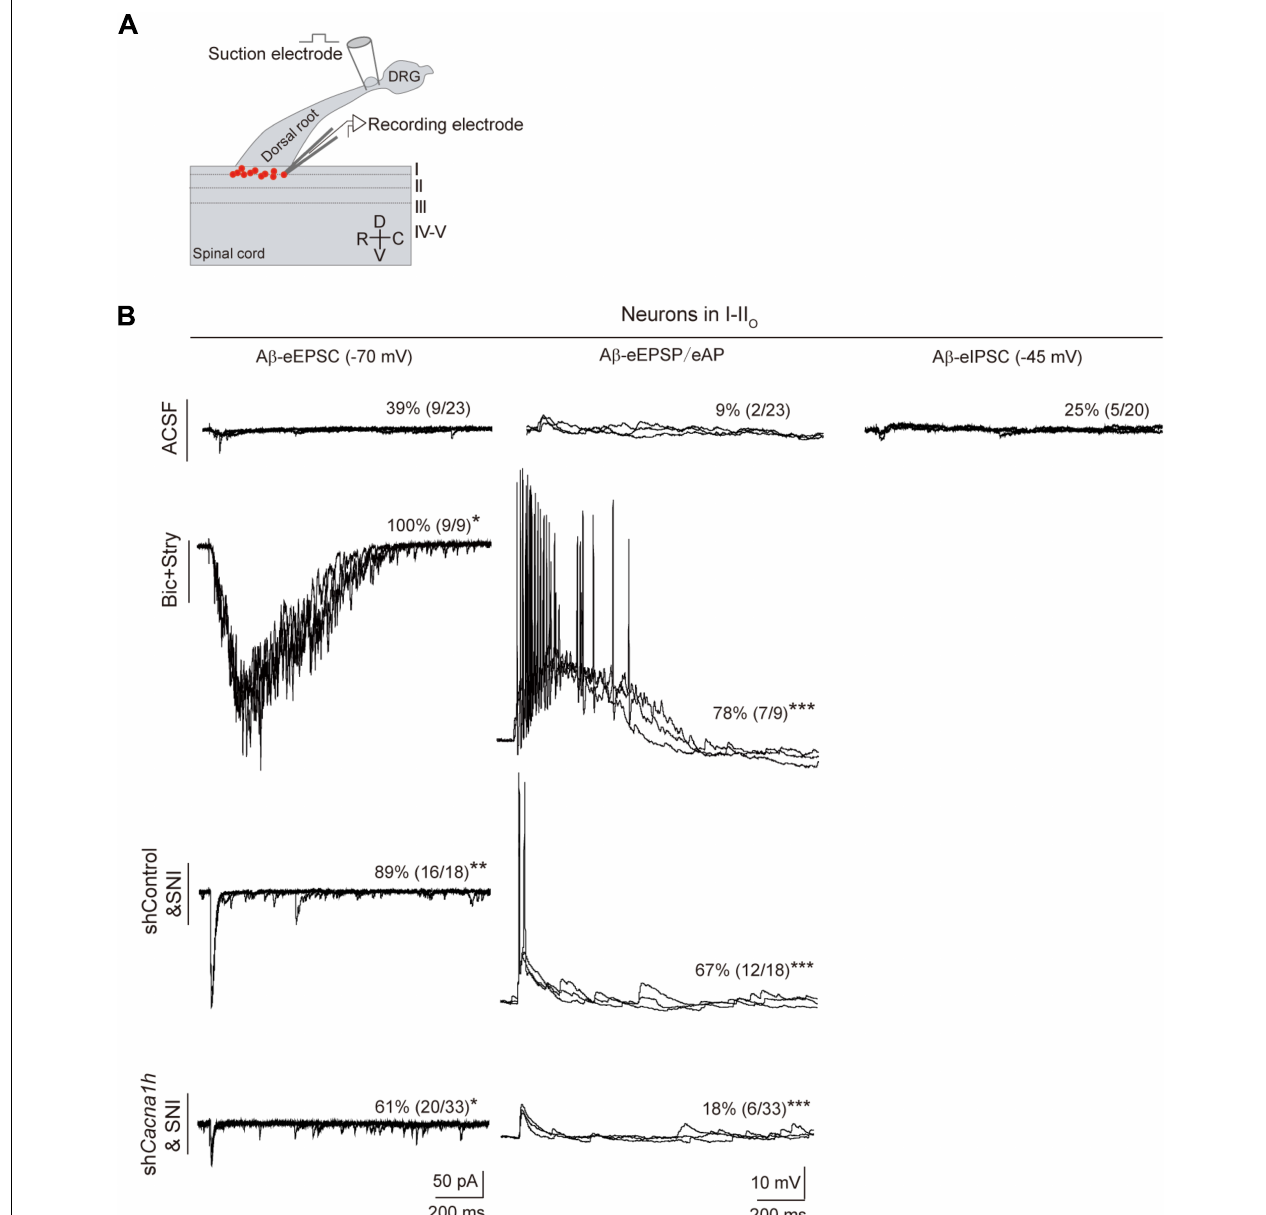
FIGURE 7 | Knockdown of Cacna1h in spinal SOM + neurons partially closed the superficial A β pathway in neuropathic pain. (A) Schematic drawing of patch clamp recordings on parasagittal spinal cord slice with dorsal root and DRG attached and recorded neurons (red dots). (B) Representative traces and percentage of neurons in laminae I-II o with A β -eEPSC (left), A β -eAP (middle) and A β -eIPSC (right) in naïve mice under normal ACSF, ACSF containing bicuculline (Bic) plus strychnine (Stry), non-silence-shRNA-injected SOM Cre mice with SNI (shControl&SNI) and Cacna1h -shRNA-injected SOM Cre mice with SNI (sh Cacna1h &SNI). All data are represented as percentage. * P < 0.05. ** P < 0.01. *** P < 0.001. Chi-square